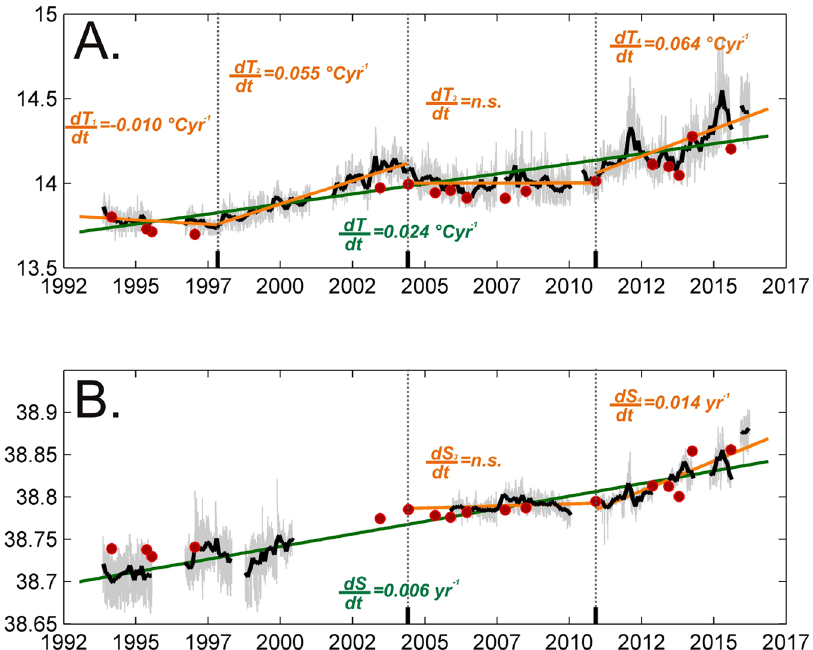
Figure 2. Time series (3-hourly in light grey) of ( A ) temperature and ( B ) practical salinity at 400 m depth (mooring C02). Red dots indicate CTD measurements from ship during servicing. The monthly mean time- series is shown in black. The green line represents the long-term trend line while short-term trends found for different periods detected by means of the change point analysis are shown in orange. For each trend line the trend value is given, if significant, in the same colour as the corresponding line. The vertical dashed lines indicate change